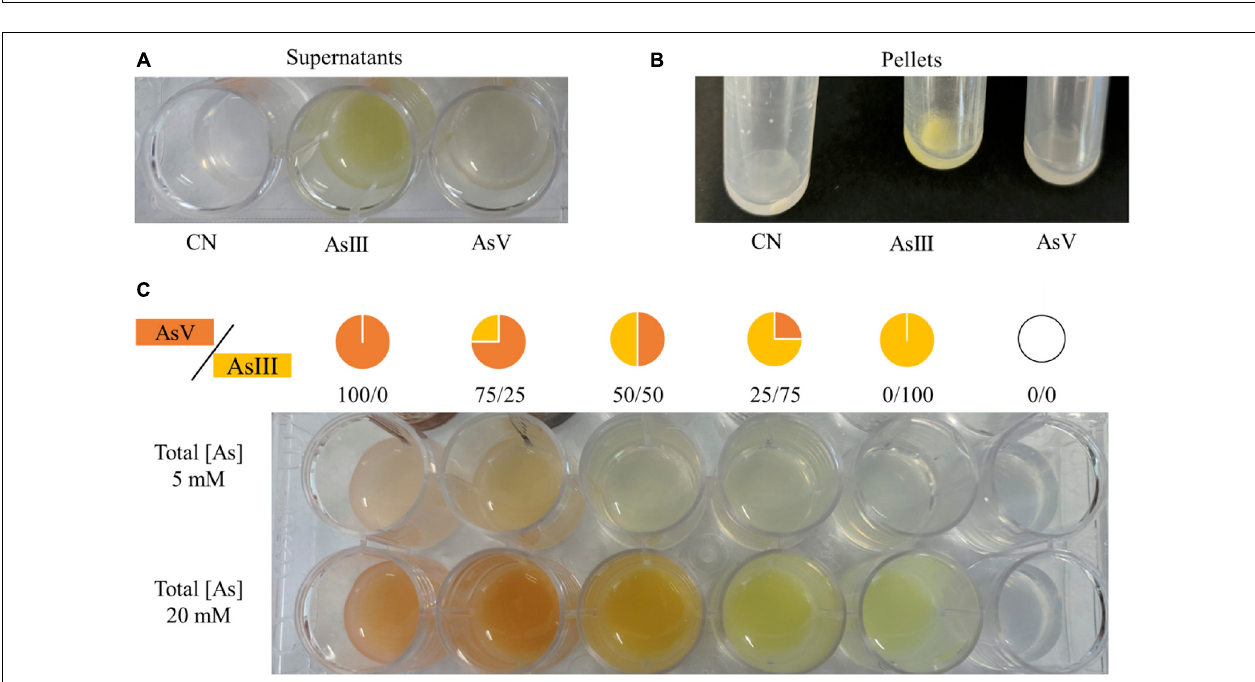
FIGURE 8 | Growth curves of A. mali FL18 in the presence of 20 mM As(III) (A) and 6 mM As(V) (B) . The red curve is the As-free control growth.